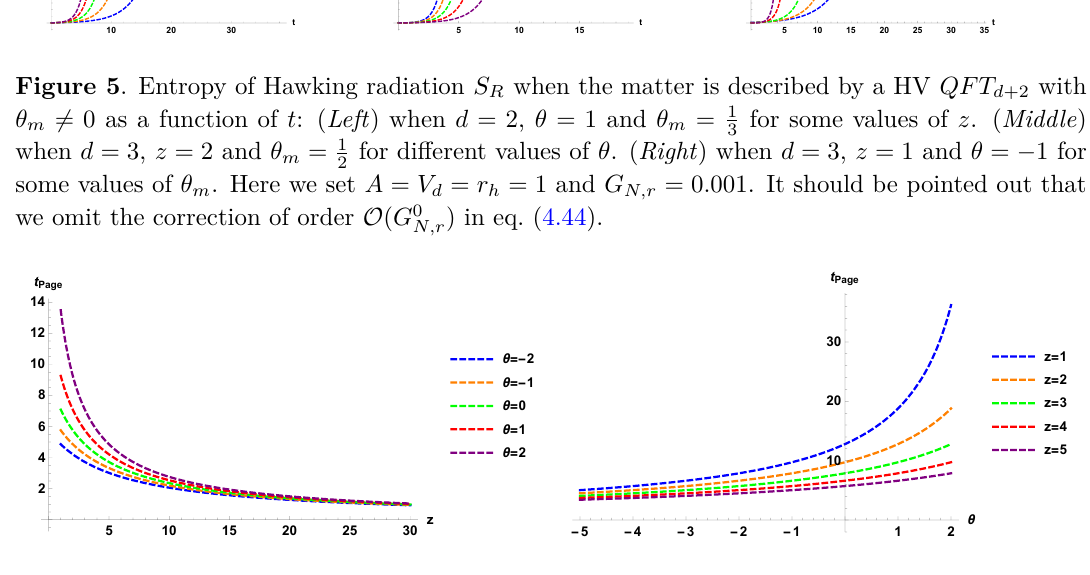
= 1 and different m 3